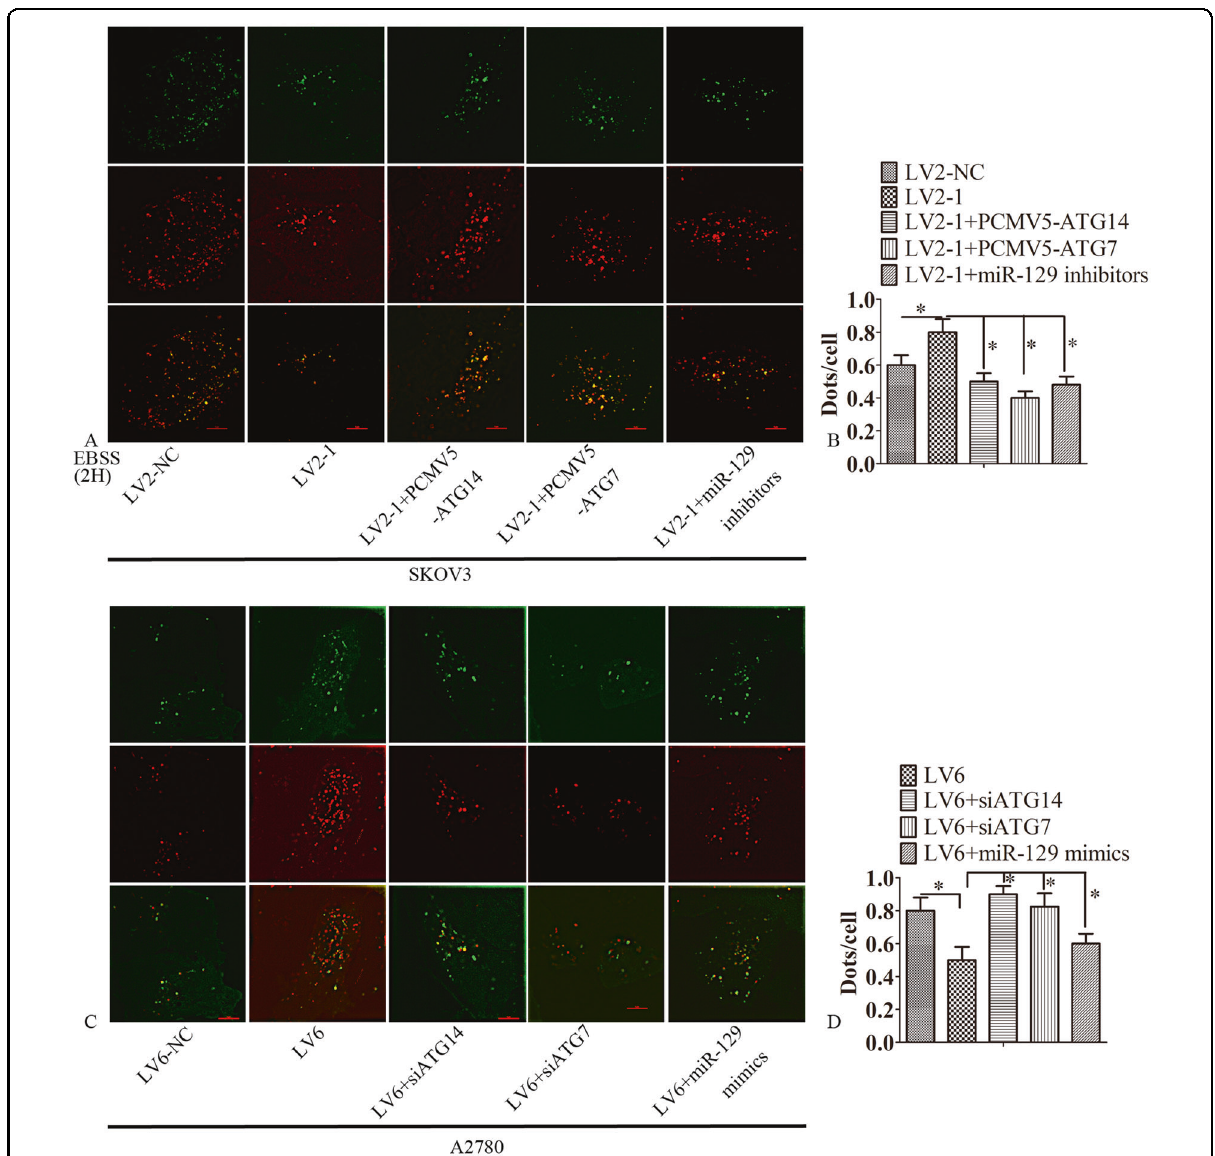
Fig. 6 CircRAB11FIP1 promoted autophagic fl ux dependent on ATG14 and ATG7. A , B LV2-NC, LV2-1, LV2-1 + PCMV5-ATG14, LV2-1 + PCMV5- ATG7, or LV2-1 + miR-129 inhibitor was transfected into SKOV3 cells. Then, confocal microscopy was performed to analyze the distribution of mRFP- GFP-LC3 in SKOV3 cells. C – D LV6-NC, LV6, LV6 + siATG14, LV6 + siATG7, or LV6 + miR-129 mimics was transfected into A2780 cells. Thereafter, confocal microscopy was conducted to analyze the distribution of mRFP-GFP-LC3 in A2780 cells. The Image-Pro Plus 6.0 was used to quantify LC3 dots. Each experiment was performed in triplicate, and typical results were displayed. Error bar represents standard error. * P < 0.05; ** P < 0.01 . Scale bar = 5